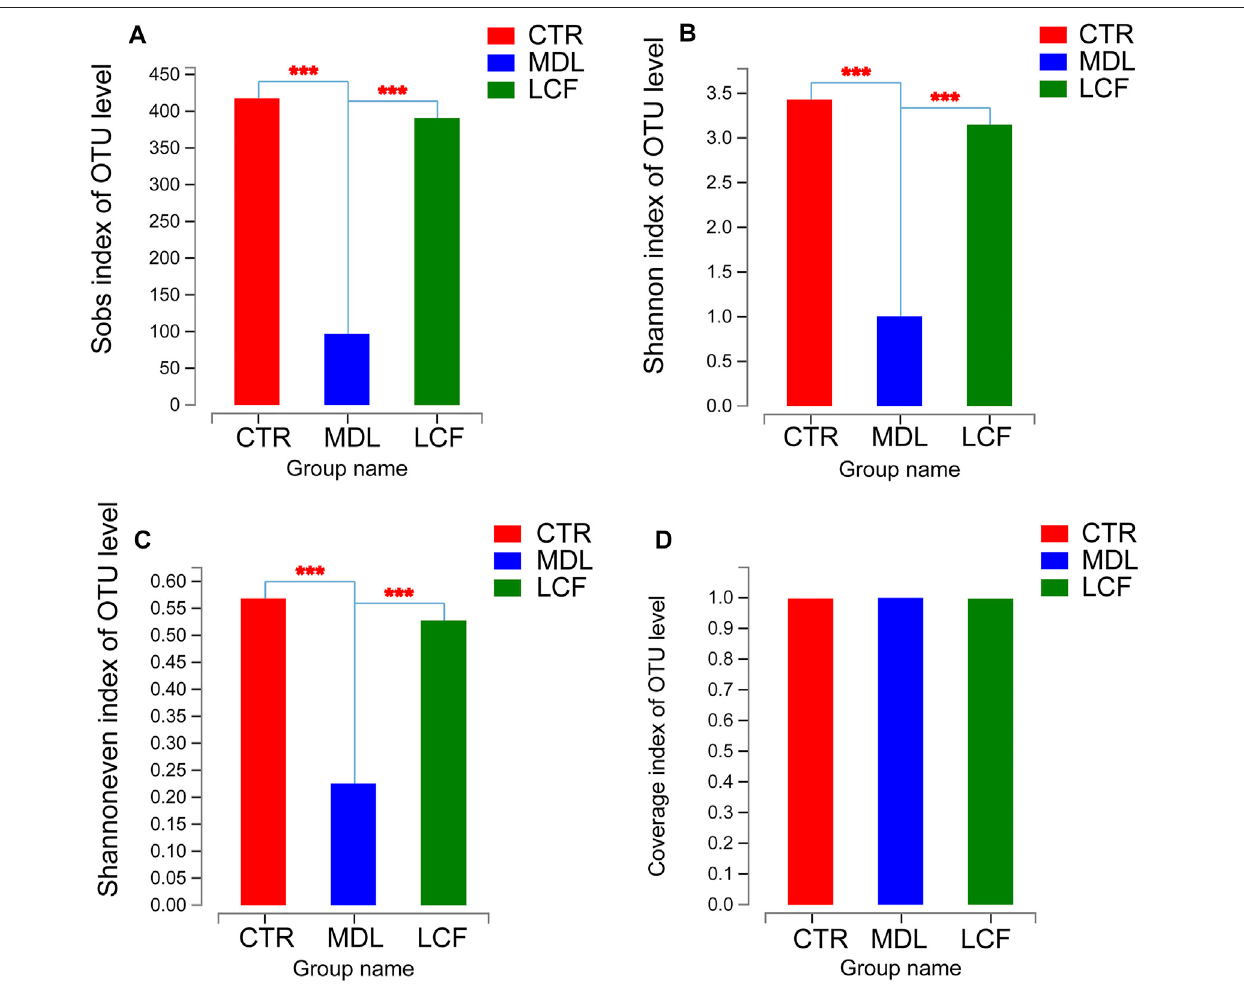
FIGURE8| AlphadiversitycomparisonsofmicrobialcommunitiesofCTR,MDLandLCF. (A) ThecalculatedSobsspeciesrichnessindicesforCTR,MDLandLCF. (B) ThecalculatedShannonspeciesdiversitypredictionsforeachgroup; (C) TheShannonevenspeciesevennessindicesforthethreegroups; (D) TheGood ’ scoverage for the community in CTR, MDL, and LCF. *** p <